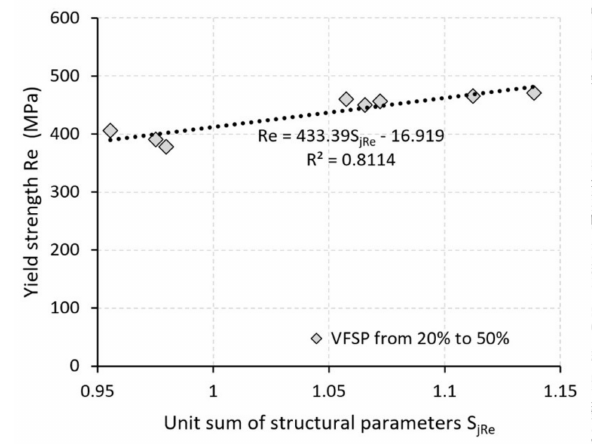
Figure 10. The dependence of the yield strength on the unit sum of the parameters of the structure.